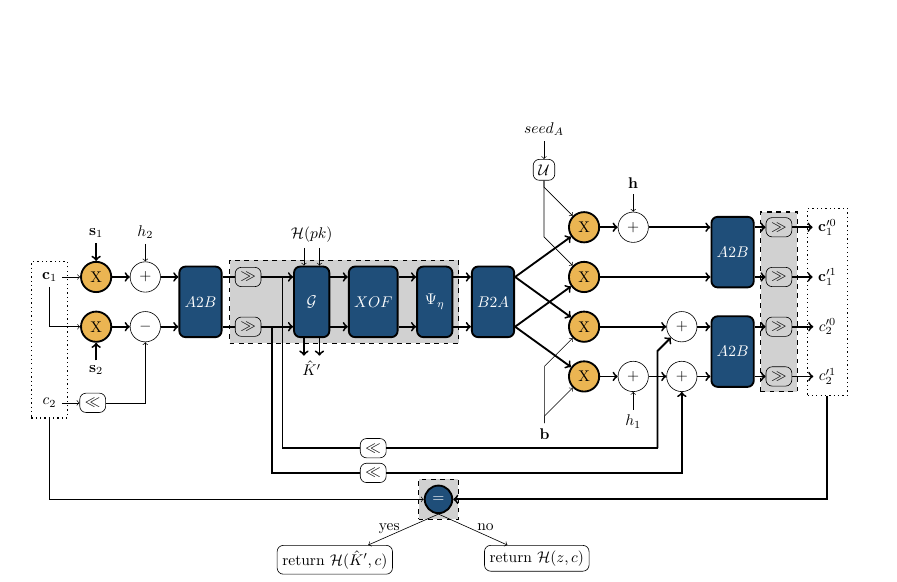
Figure 1: Masked decapsulation of Saber [BDK + 21]. Linear performance bottlenecks highlighted in yellow, non-linear masked routines highlighted in blue, operations that require Boolean masking grouped in light grey.